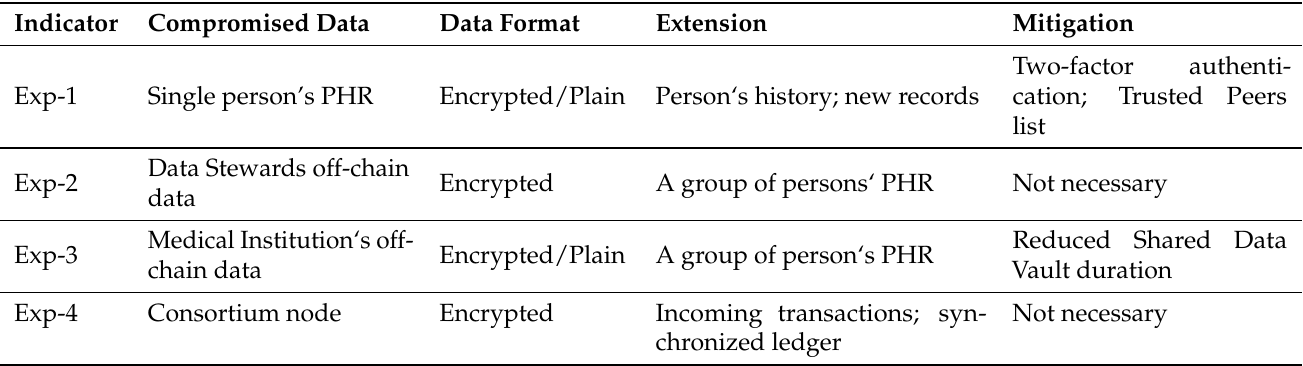
Table 8. Security and privacy